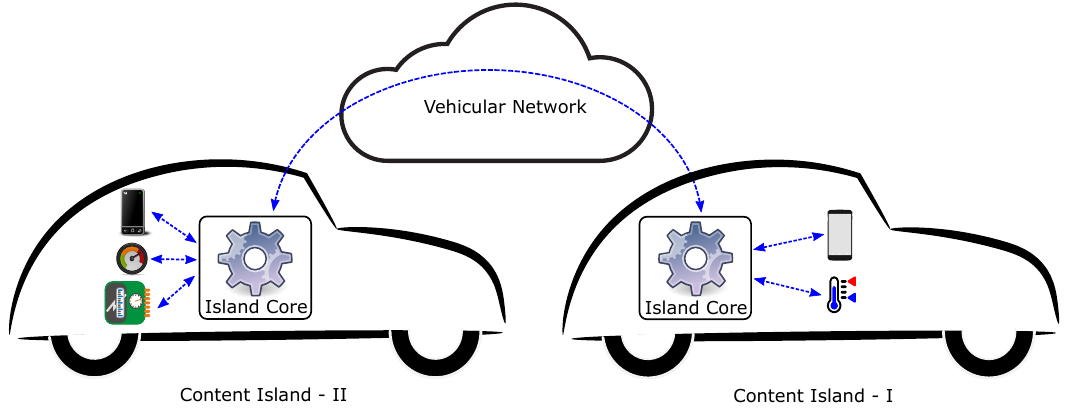
Figure 1. Concept of the island